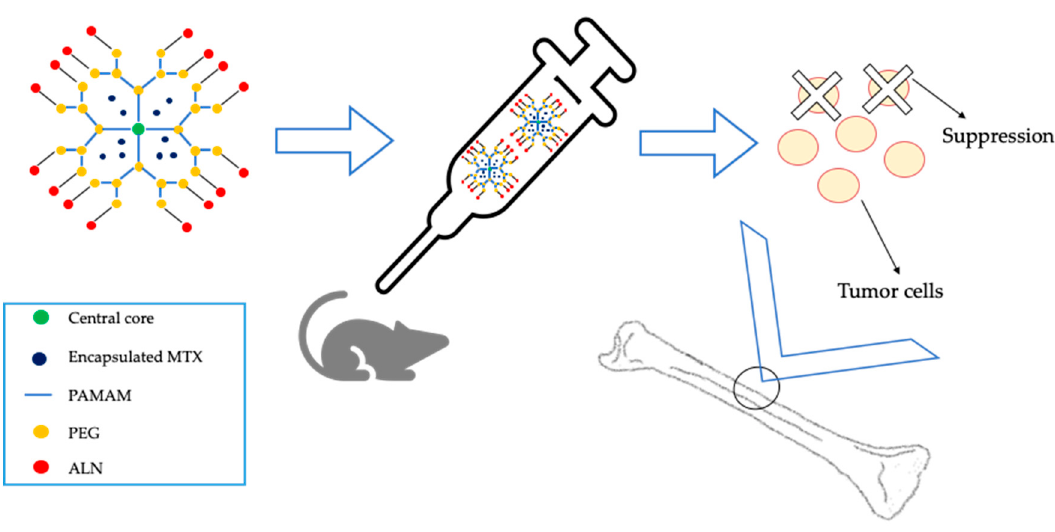
Figure 1. Schematic representation of methotrexate (MTX)-encapsulated dendrimers for the treatment of bone metastasis which allow the suppression of tumor cells in mice.